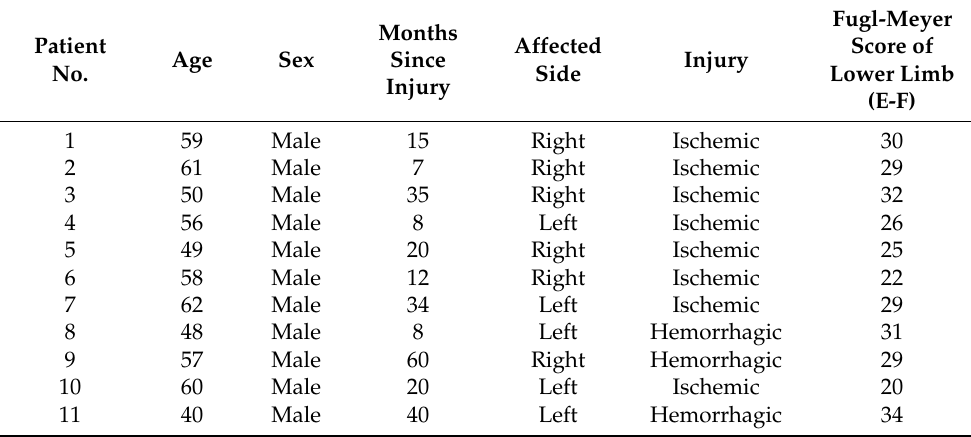
Table 1. Demographics of the patients who participated in this